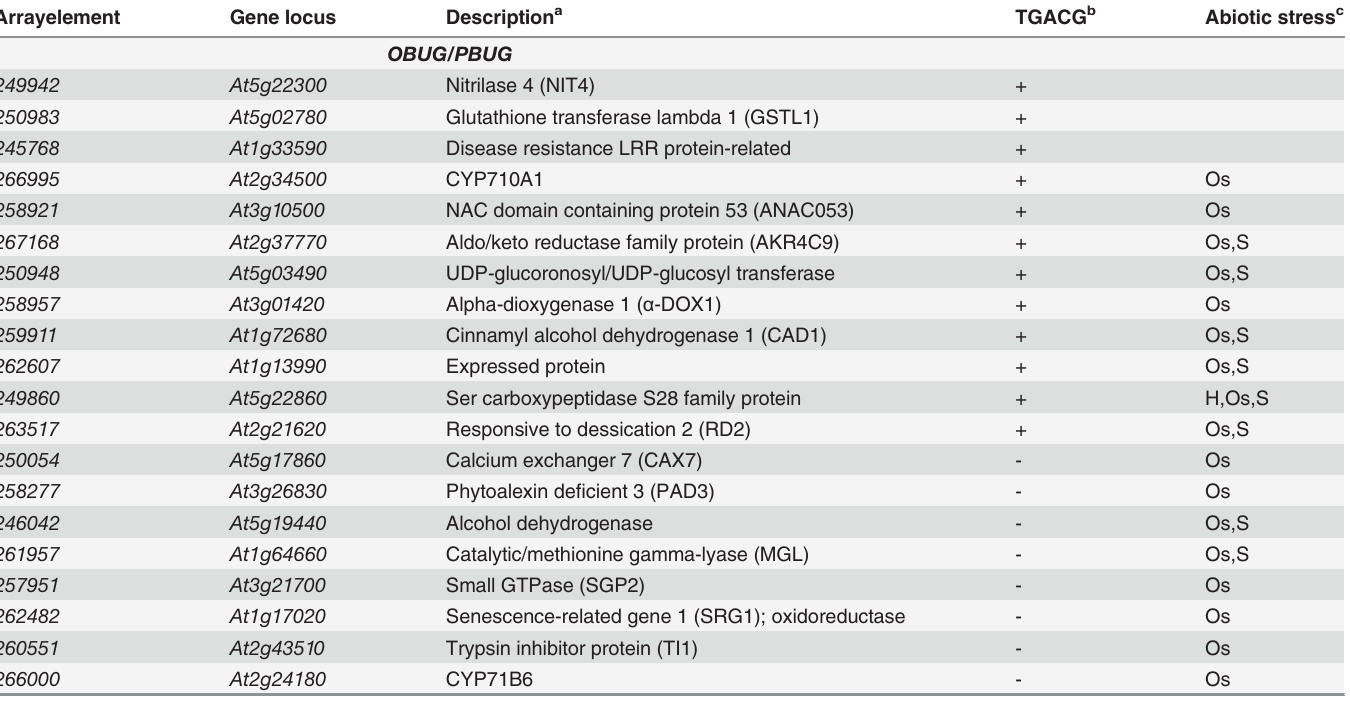
Table 5. Upregulated genes by OBUG s and PBUG s, and abiotic stresses dependent on TGA2/5/6 .